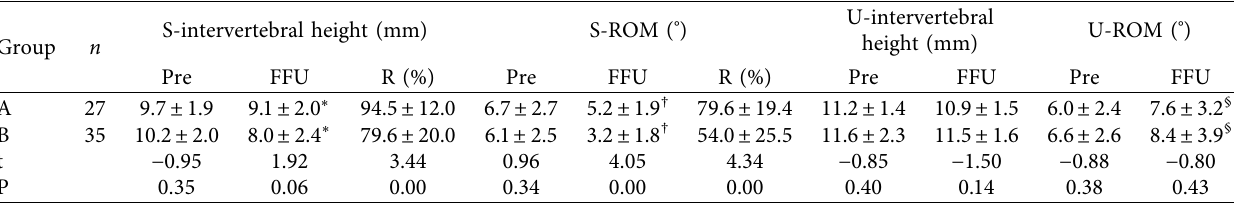
Table 2: Radiography outcomes.